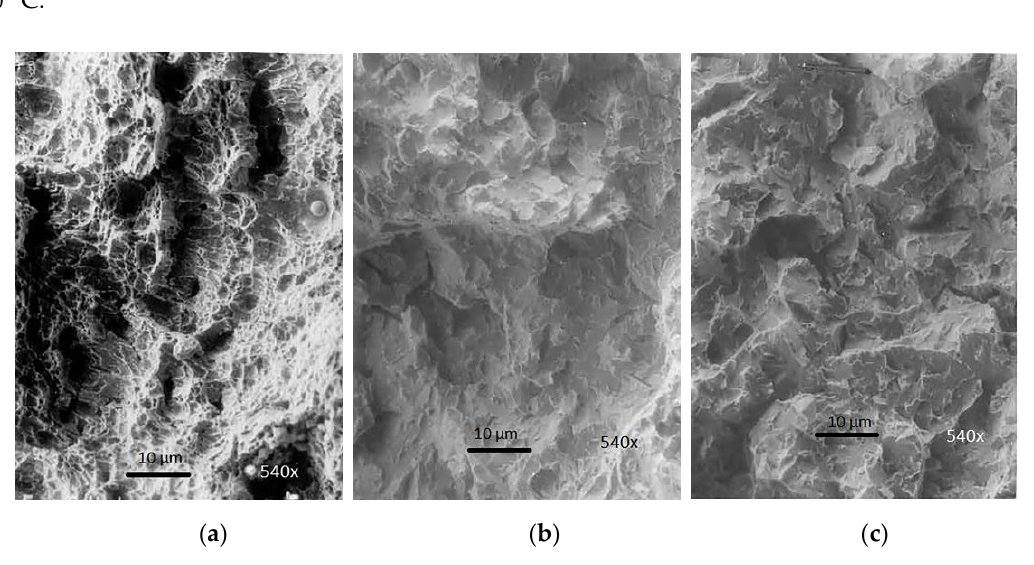
Figure 8. SEM fracture surface view after testing the toughness of WM created by the electrode No.1.2: ( a ) ( t = + 20°C), ductile fracture with tiny pits containing deposited particles; ( b ) ( t = −40 °C), mixed- mode fracture, which is predominantly transcrystalline; ( c ) ( t = −60 °C), transcrystalline brittle fracture with the presence of microvoids in the middle of WM.